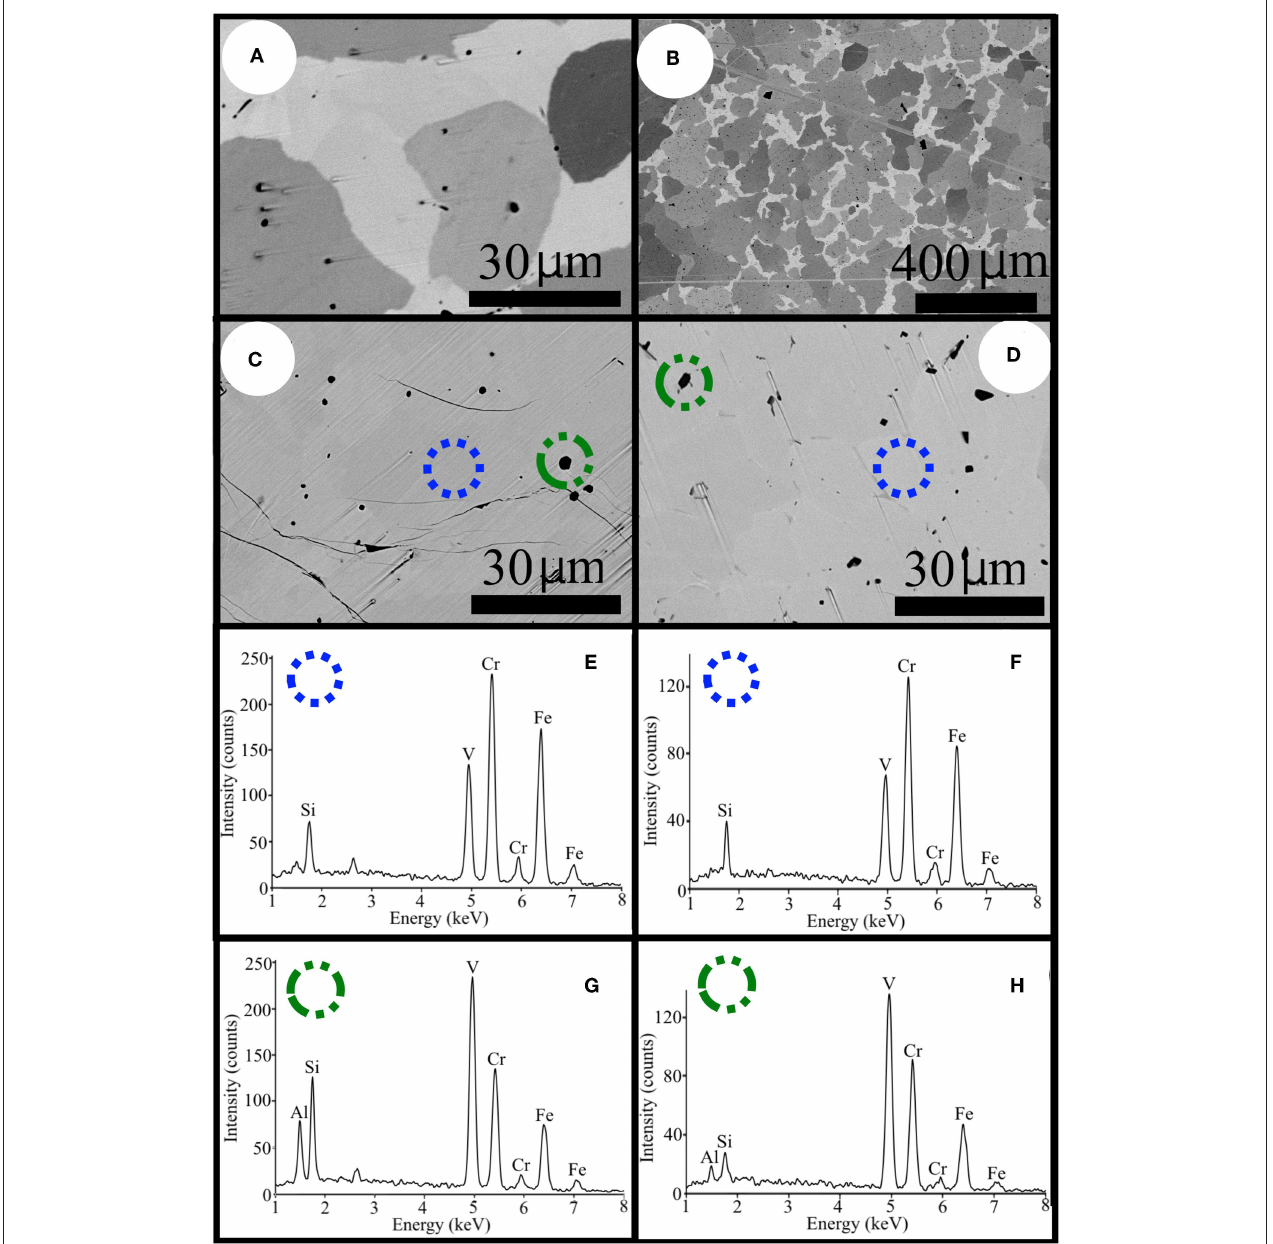
FIGURE 8 | Backscattered electron images of SiFeVCr, (A,B) as-cast, (C) after annealing at 981 ◦ C (0.5 T m ) for 48h, and (D) after annealing at 1276 ◦ C (0.65 T m ) for 48h. EDX spectra (E,G) collected from the sample annealed at 0.5 T m , and (F,H) from the sample annealed at 0.65 T m